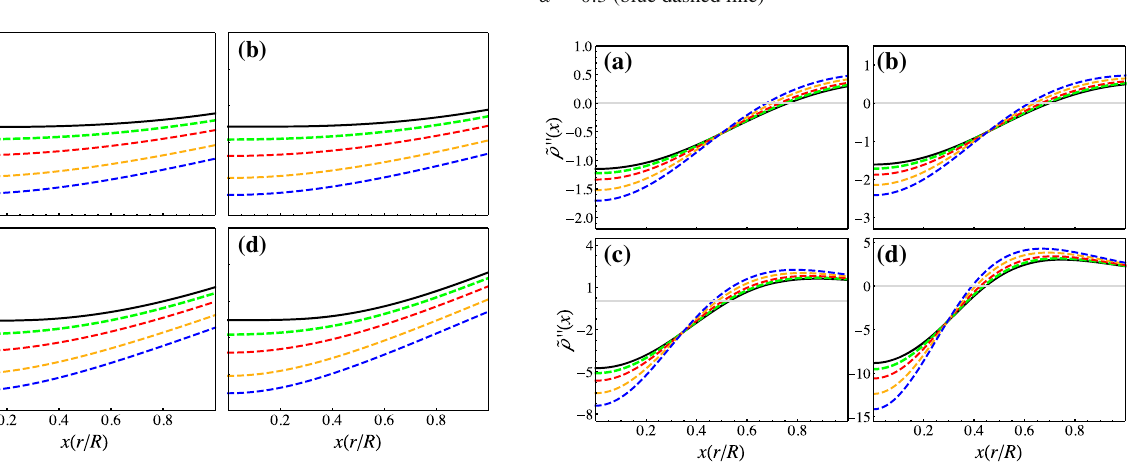
Fig. 10 Second derivative of the density, ˜ ρ for a u = 0 . 13, b u = 0 . 15478, c u = 0 . 2035, d u = 0 . 229365. α = 0 (black solid line), α = 0 . 04, (green dashed line), α = 0 . 1 (red dashed line), α = 0 . 2 (yellow dashed line), α = 0 . 3 (blue dashed line) ˜ ρ (cid:3)(cid:3) ≤ 0